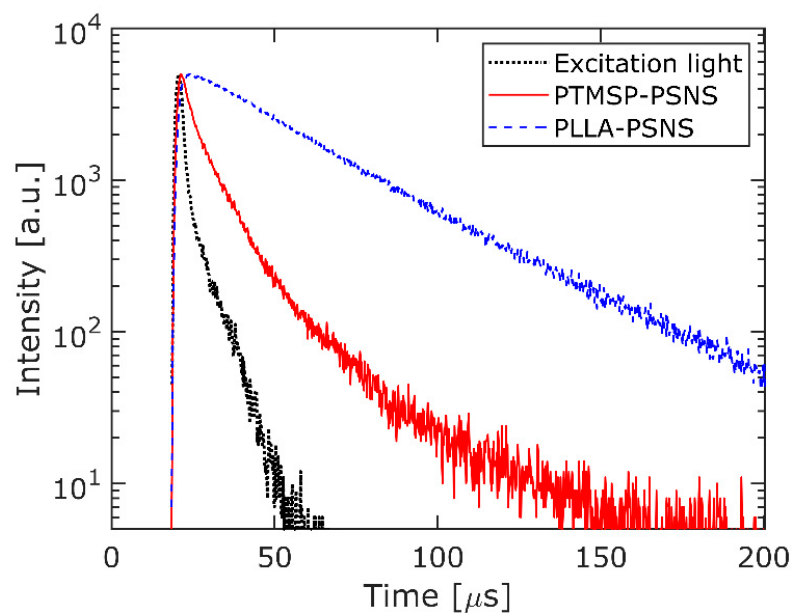
Figure 5. Phosphoresence decay curves for PTMSP-PSNS and PLLA-PSNS.